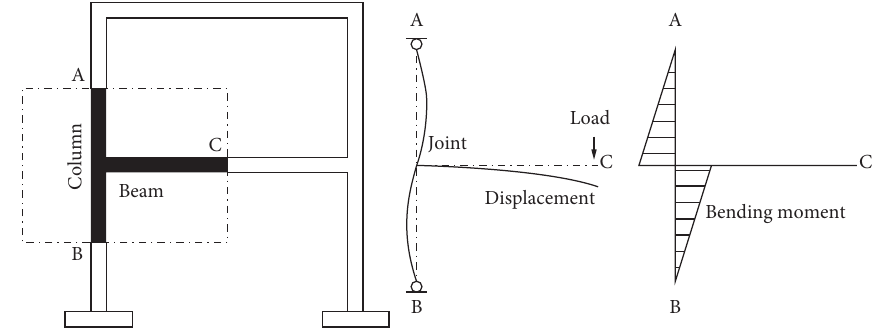
Figure 10: Bending moment diagram for the column member.